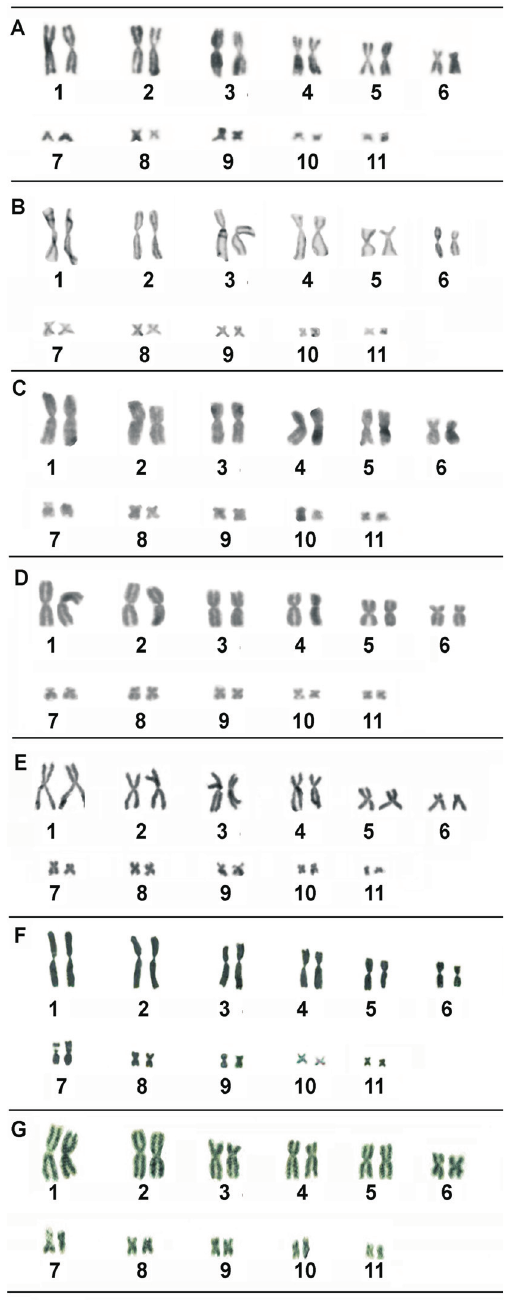
Figure 1 - Karyotypes of five species of the Rhinella margaritifera (A-E) and Rhinella marina (F-G) groups from Brazil, based on Giemsa staining: (A) R. hoogmoedi ; (B) R. proboscidae ; (C) Rhinella sp. 1; (D) Rhinella sp. 2 and (E) Rhinella cf. margaritifera ; (F) R. ictarica from Sertão, RS; (G) R. henseli, from Sertão, RS . Figure 2 - Karyotypes of five species of the Rhinella margaritifera (A-E)